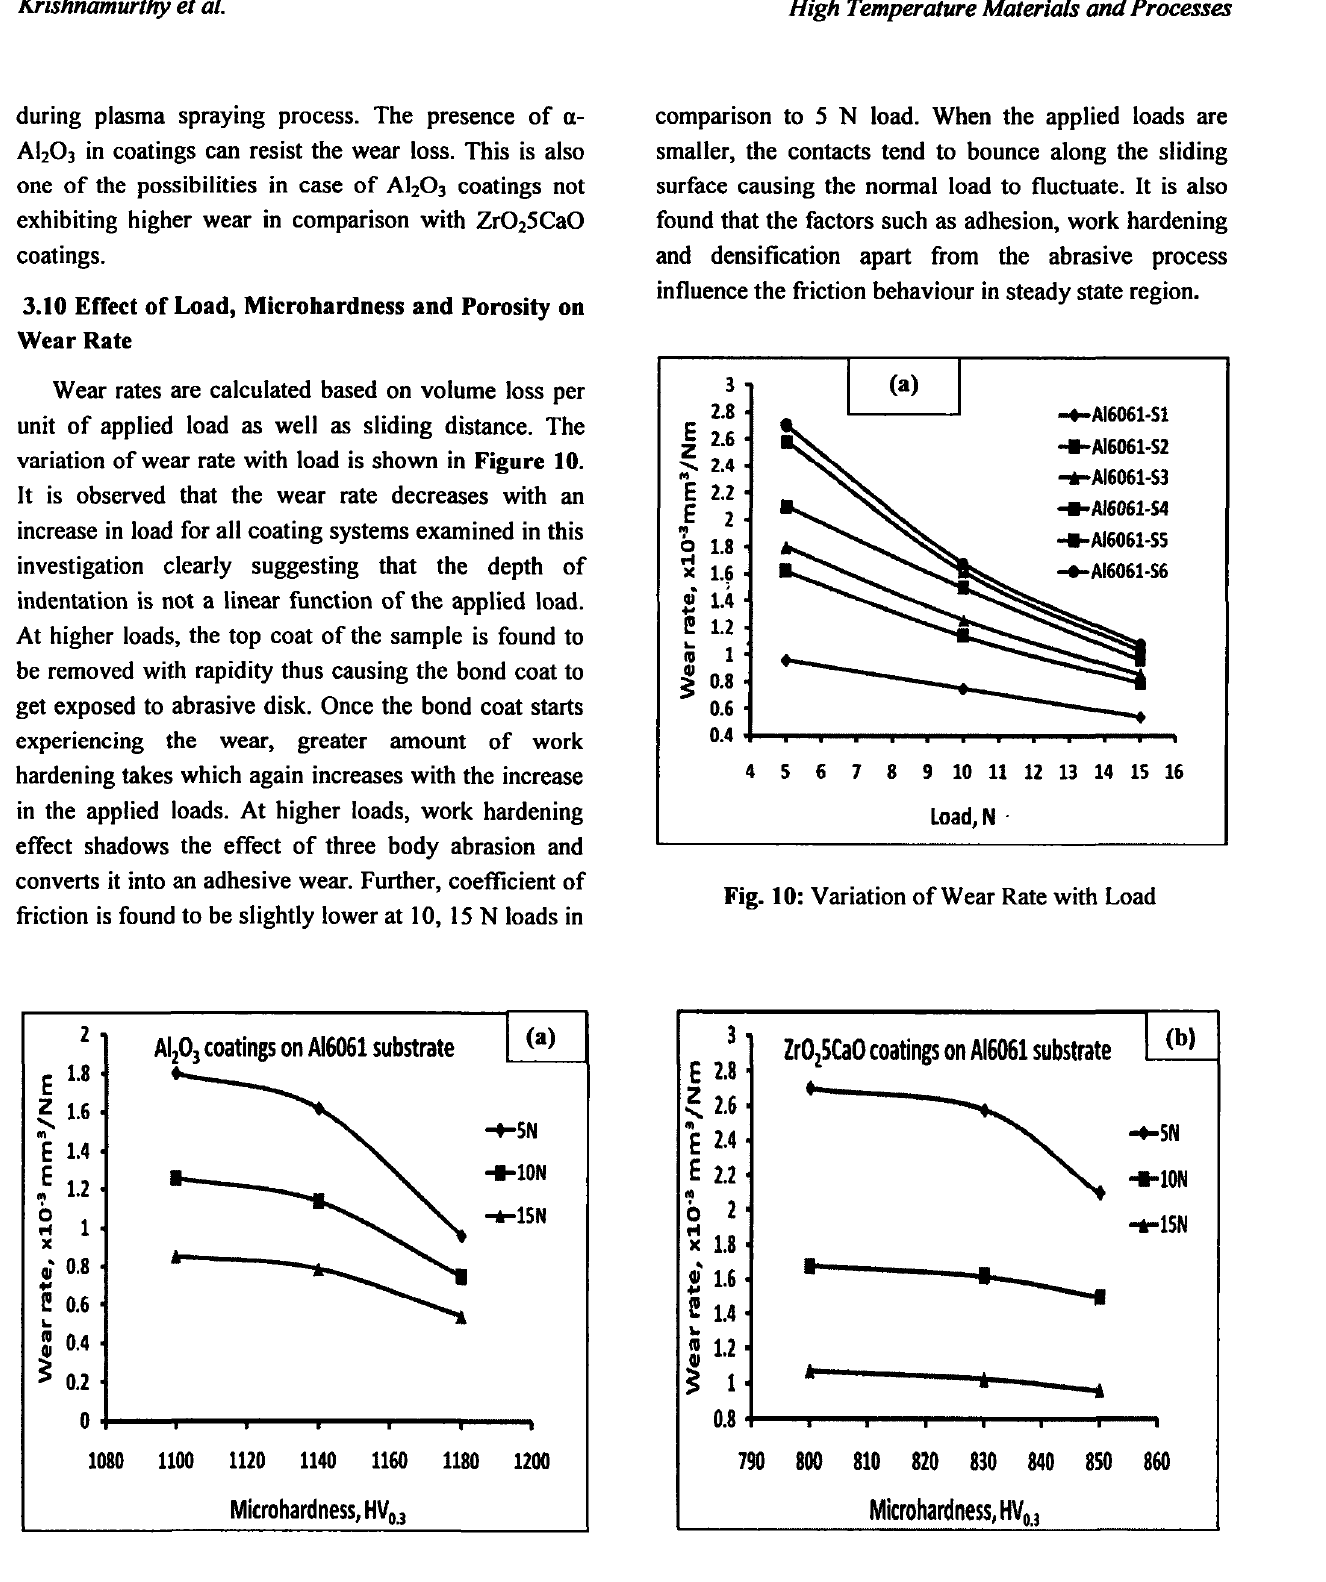
Fig. 11: Variation of Wear Rate of Coatings with Top Coat Microhardness (a) Alumina (b) ZrO